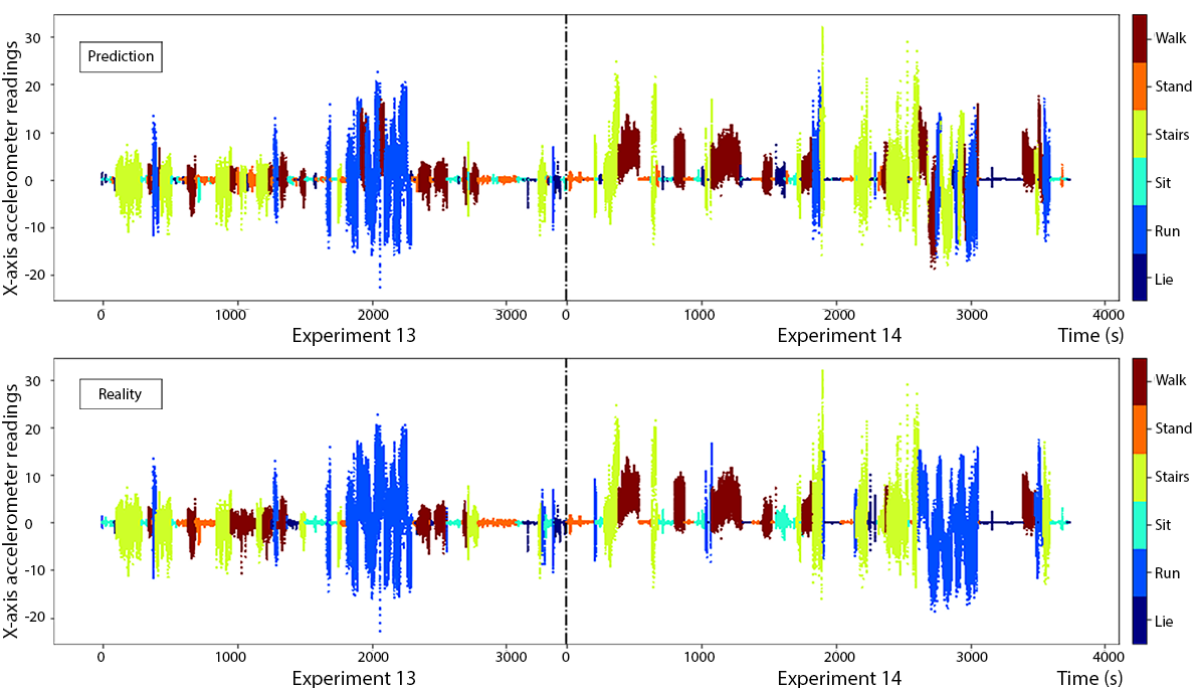
Figure 13. Instantaneous predictions using greedy Gaussian segmentation (top) and ground truth (bottom) from the 2 test experiments (13 and 14) in the BREATHE dataset.